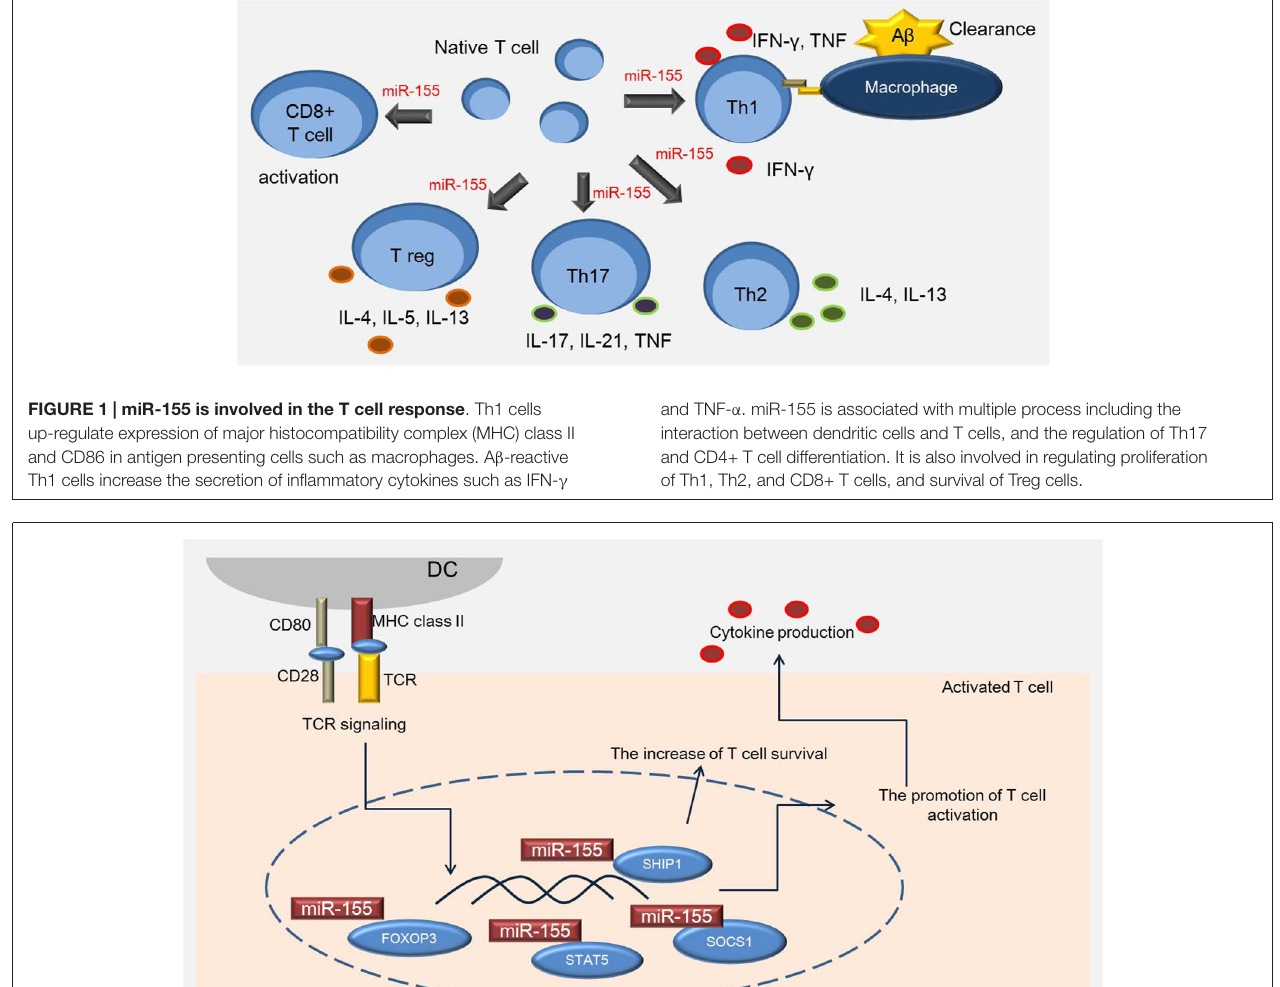
role in Treg cell survival in vivo , and regulates the phosphorylation of STAT5 and SOCS1. SHIP1 increases the survival of T cells by modulating IFN- γ